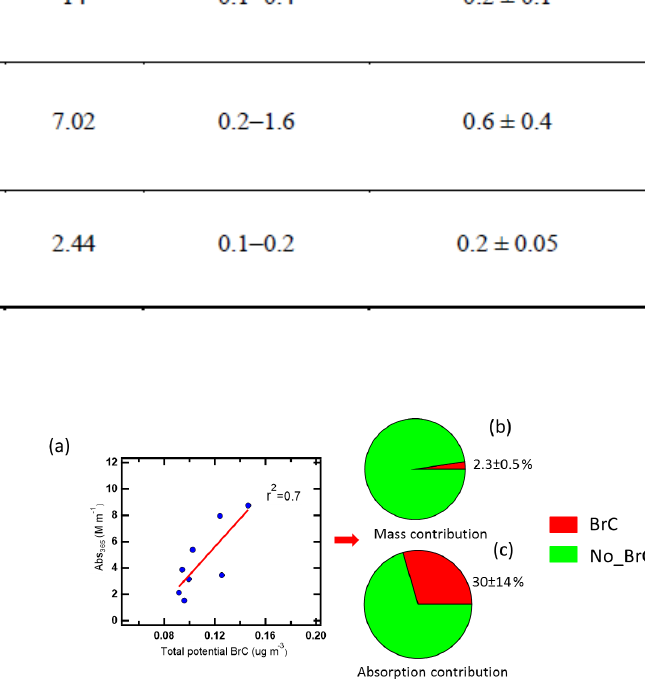
Figure 6. The correlation of Abs 365 and total potential BrC (a) . Mass (b) and absorption (c) contribution of the total potential BrC. The red pie: BrC; the green pie: